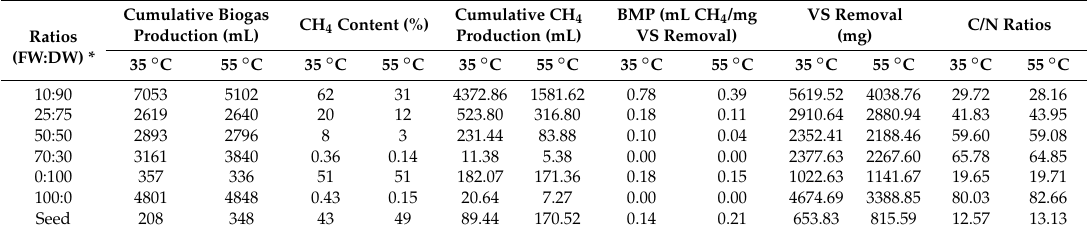
Table 2. Performance data for batch experiments with various ratios of co-substrate under mesophilic (35 ◦ C) and thermophilic (55 ◦ C)